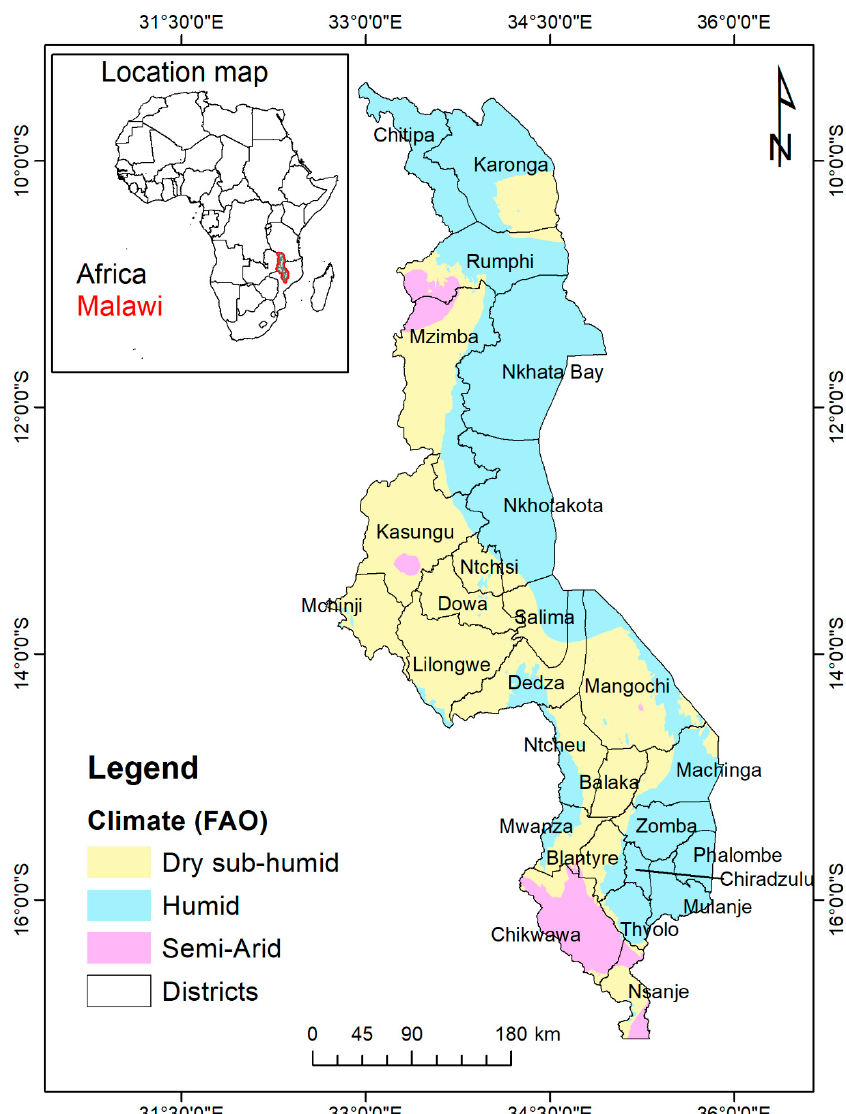
Figure 1. Study area in Malawi showing agro-ecological zones with sub-national boundaries.